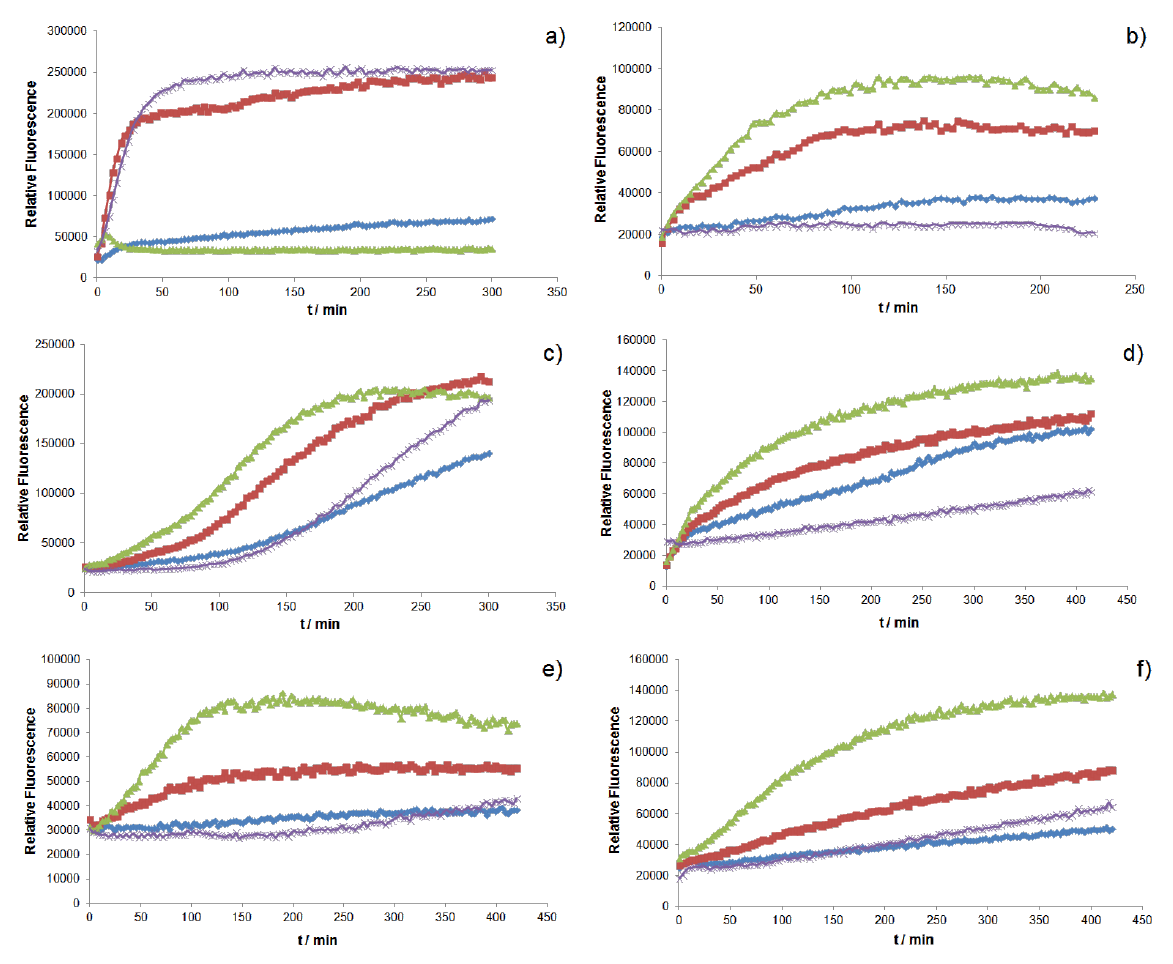
Figure 3: Fluorescence evolution resulting from closing metathesis of fluorescence–quencher substrate 5 ( λ excitation = 320 nm and λ emission = 400 nm). Different catalysts 1 – 4 ( 1 : blue; 2 : red, 3 : green, 4 : purple) were screened in different solvents (a: acetic acid; b: 2-methylpentanone; c: toluene; d: o -xylene; e: γ -butyrolactone; f: anisole).